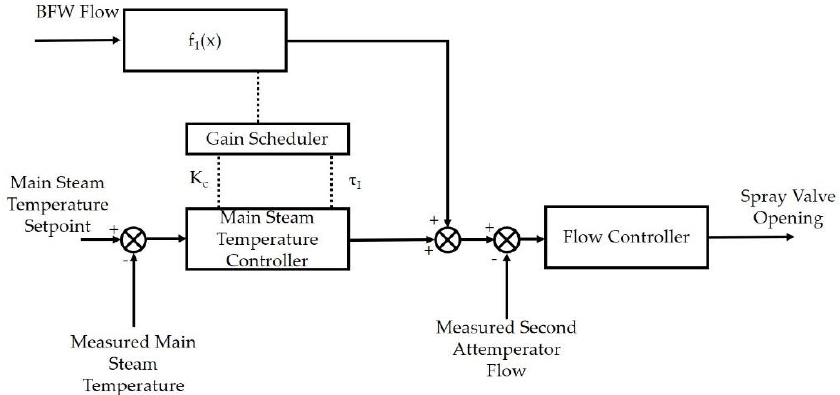
Figure 8. Configuration 1 Control Scheme for Main Steam Temperature.